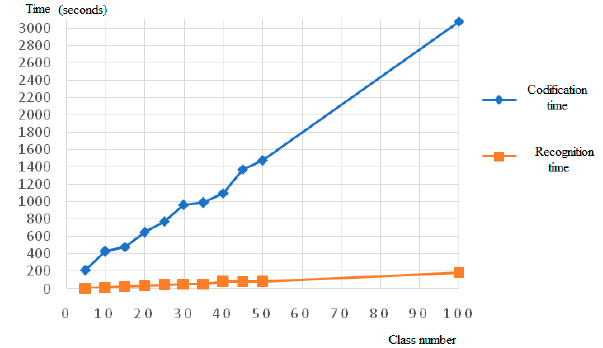
Figure 21. Coding and recognition time for PCNC.